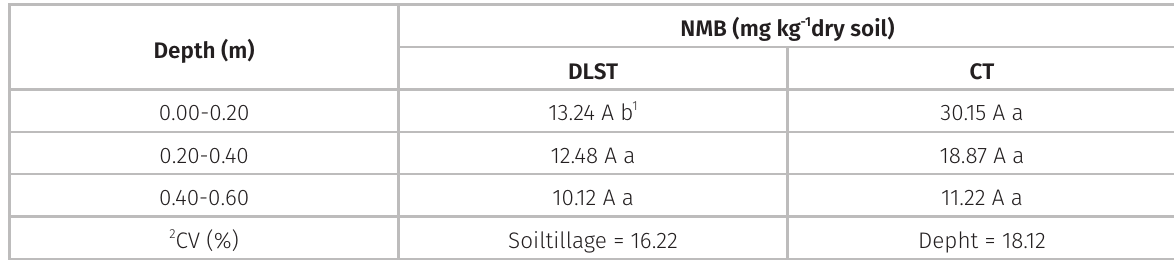
Table III. Nitrogen microbial biomass (NMB) in a dystrophic Red-Yellow Latosol under conventional tillage (CT) and deep localized soil tillage